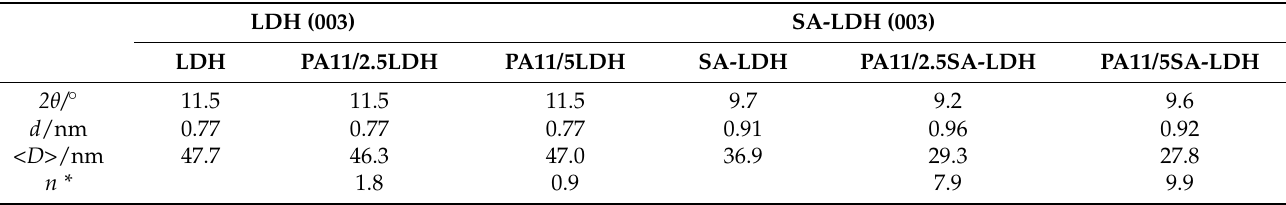
Table 1. XRD data of PA11 and its composites.